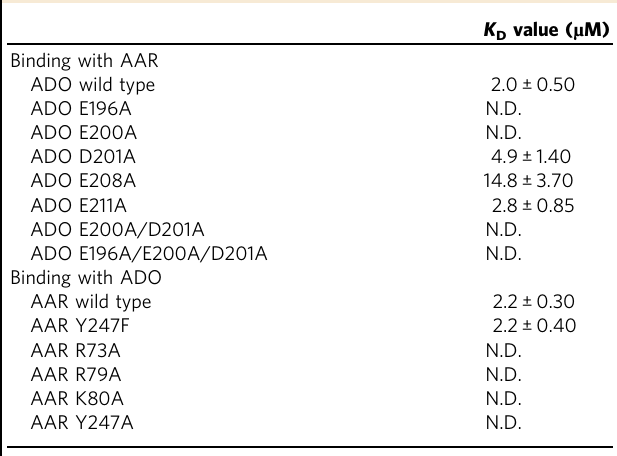
Table 2 Binding af fi nity between AAR and ADO measured through ITC method.